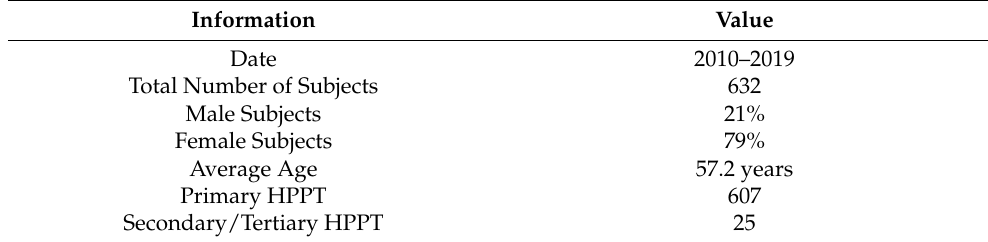
Table 1. Characteristics of the study’s